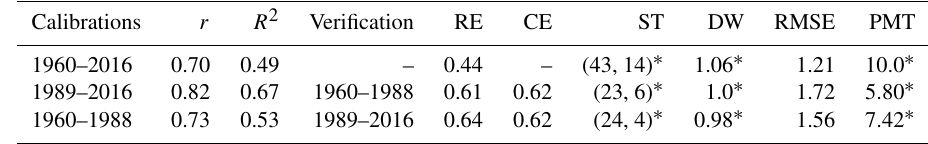
Table 1. Statistical test for the tree-ring reconstruction of the March–August PDSI in the Chitral Hindu Kush range of northern Pakistan based on a split calibration–verification procedure. Calibrations r R 2 Verification